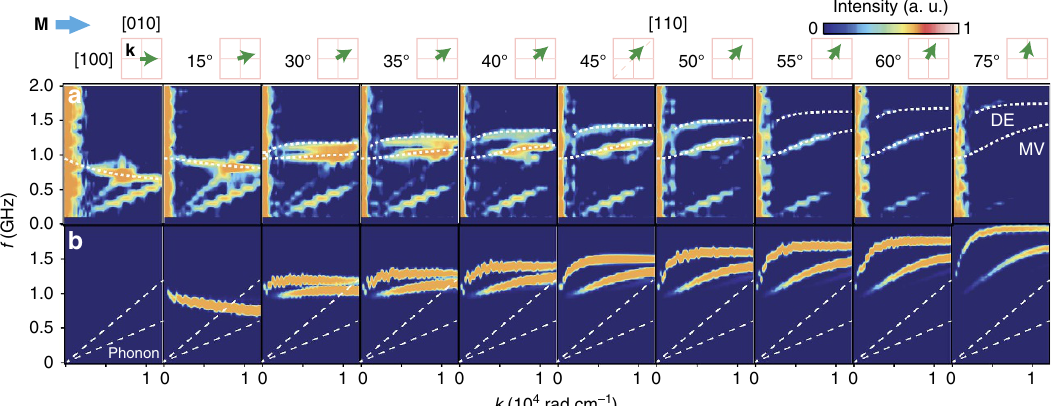
Figure 3 | Angular dependence of SWaTspectra. ( a ) Experimentally obtained angular dependence of the SWaTspectra for various k directions. The angle ( f ) between k and M is shown at the top of each figure. The branches of spin waves labelled as DE and MV represent the magnetostatic Damon–Eshbach and magnetostatic volume modes, respectively. The white dashed curves are calculated by magnetostatic spin wave theory 4 . ( b ) Spin-wave dispersion obtained by a micromagnetic simulation (see text) with the same parameters as in ( a ). The white dashed lines represent the phonon dispersion.